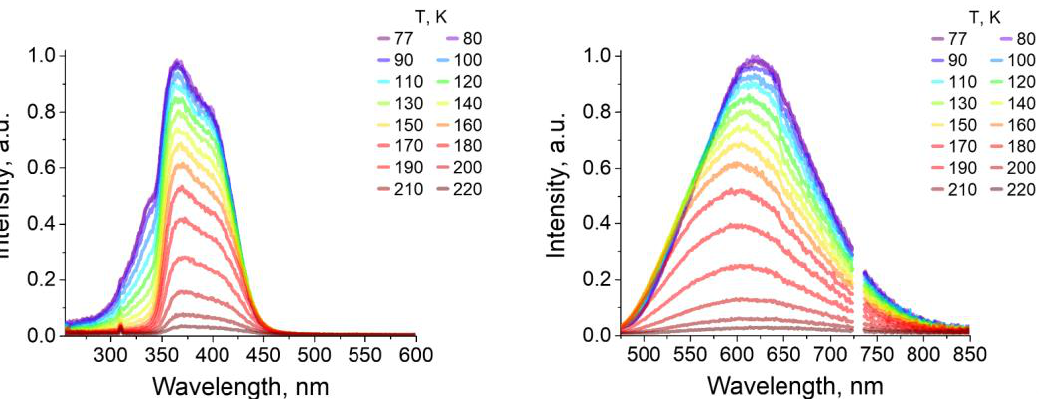
Figure 7. Temperature dependence of the PLE spectra ( λ Em = 620 nm) of 1 ( left ); temperature dependence of the PL spectra ( λ Ex = 365 nm) ( right ).